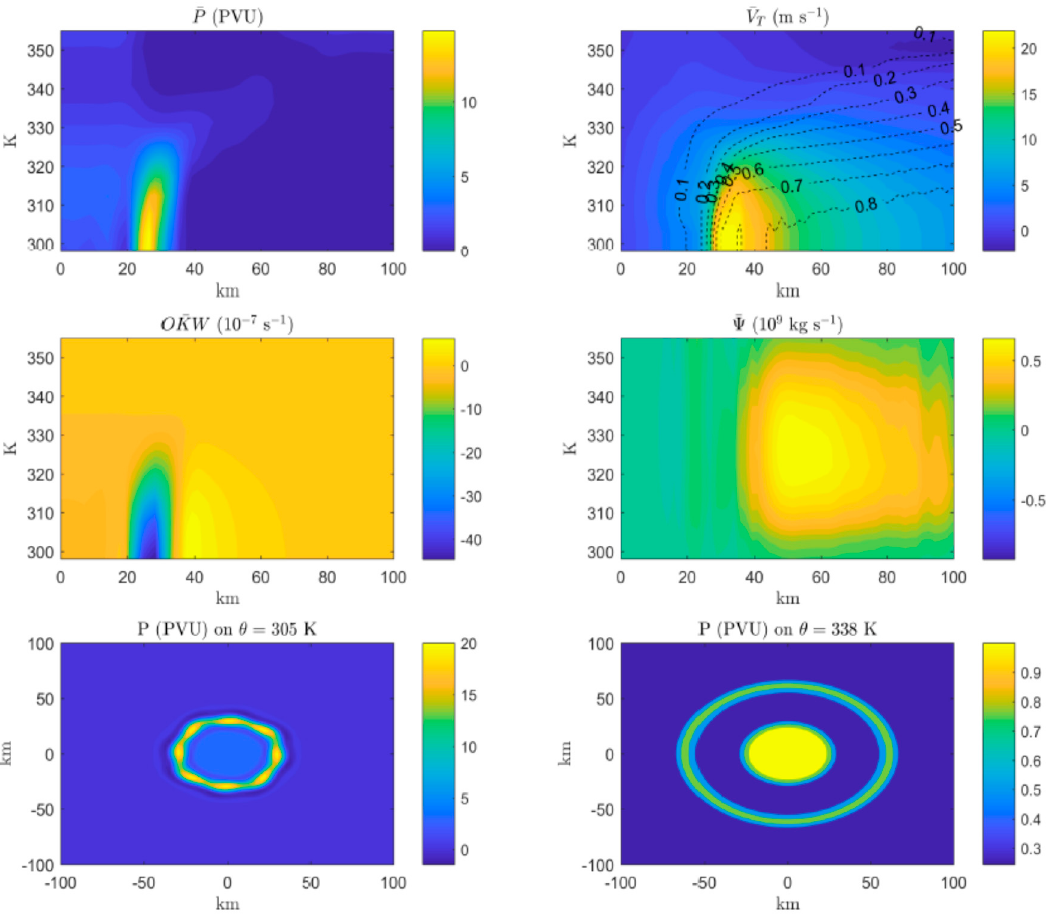
Figure 4. Same as Figure 2, except for (cid:1872) = 9 h